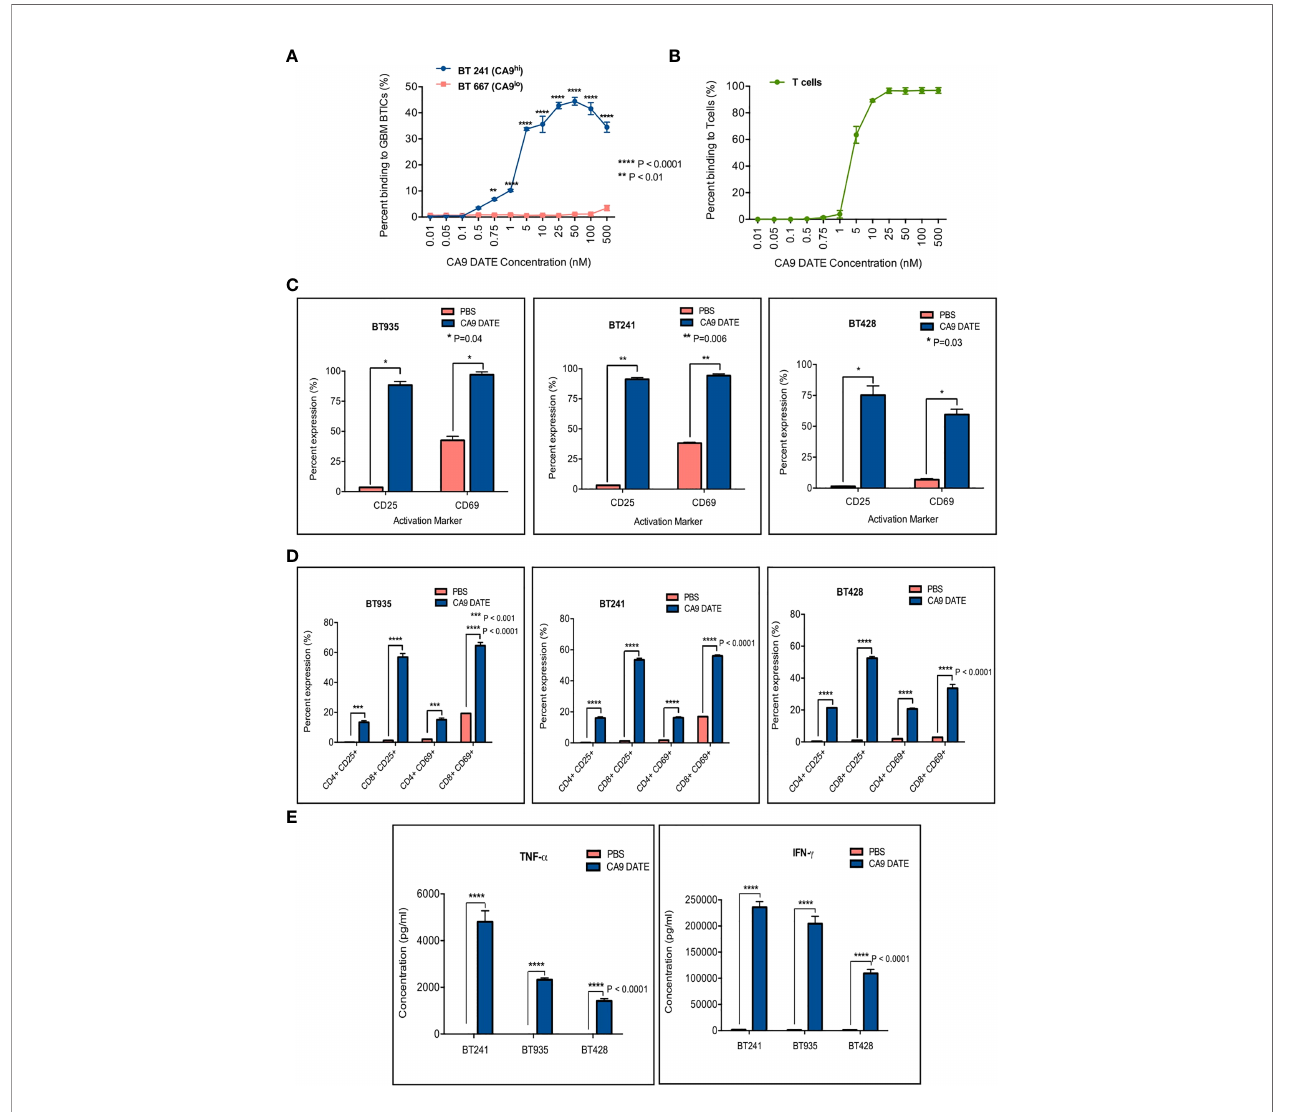
FIGURE 5 | Assessment of anti-CA9 Dual speci fi c T cell engagers (DATEs) dual speci fi city and its effect on GBM model. (A) Dual speci fi city of CA9 DATEs on CA9hi GBM BTIC (BT241), CA9low GBM BTIC (BT667) and (B) human PBMC derived T cells by fl ow cytometry. (P value: **<0.01, **** <0.0001) (2-way RM AVOVA). (C) Addition of CA9 DATE (1µg/mL) (13nM) to the co-culture of CA9hi GBM BTICs (BT241, BT935, BT428) and T cells (E:T ratio, 1:1) (overnight incubation) caused T cells activation as con fi rmed by increased expression of CD25 and CD69 by fl ow cytometry analysis (n=2). (P value: *= 0.04, **= 0.006) (2 way ANOVA) (D) CD8+ T cells were the main subset of activated T cells. (P value: ***< 0.001, **** < 0.0001) (2 way ANOVA) (E) Enzyme-linked immunosorbent assay (ELISA) shows elevated secretion of IFN- g and TNF- a cytokines in supernatant collected from co-cultures ofT cells and GBM BTICs treated with CA9 DATEs. (n=2) (P value: **** <